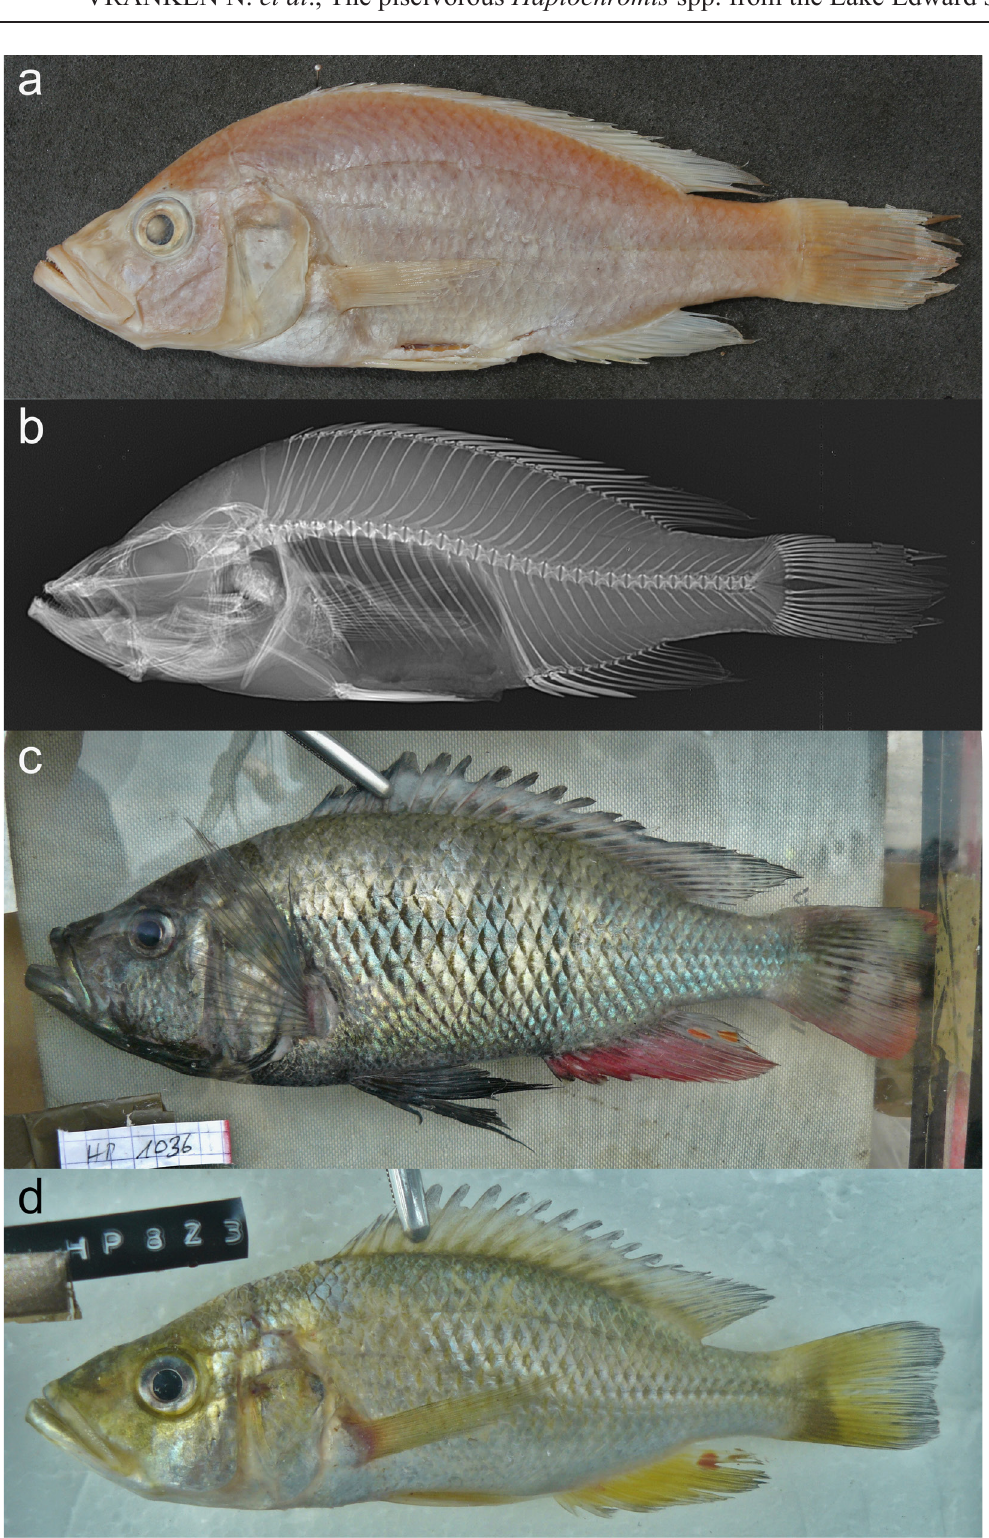
Fig. 39. Haplochromis squamipinnis Regan, 1921. a . Photograph of preserved holotype (NHMUK 1914.4.8.32; 136.9 mm SL). b . X-ray image of holotype. c – d . Photographs of freshly caught specimens. c . Dominant male (RMCA 2016.035.P.0250; 169.7 mm SL). d . Female (RMCA 2016.035.P(HP823); 129.6 mm SL) to illustrate the live colour patterns. The contrast was slightly